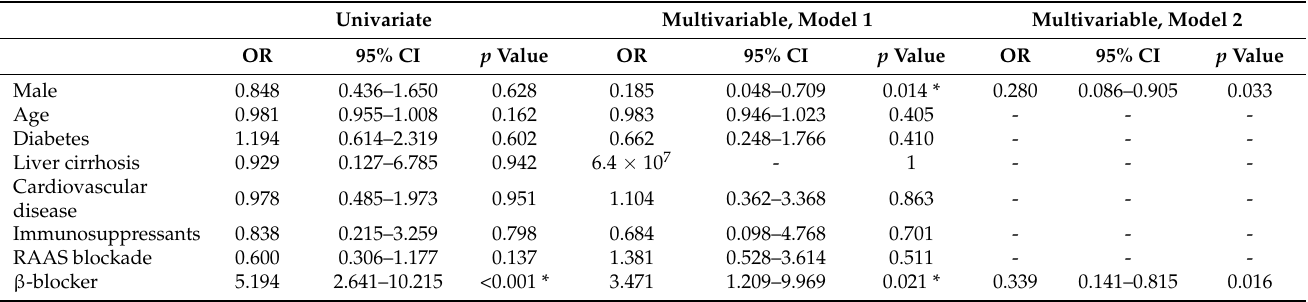
Table 4. Logistic regression analysis of factors associated with positive humoral response (NT 50 > 35.13 IU/mL) to booster dose in first-dose seronegative HD